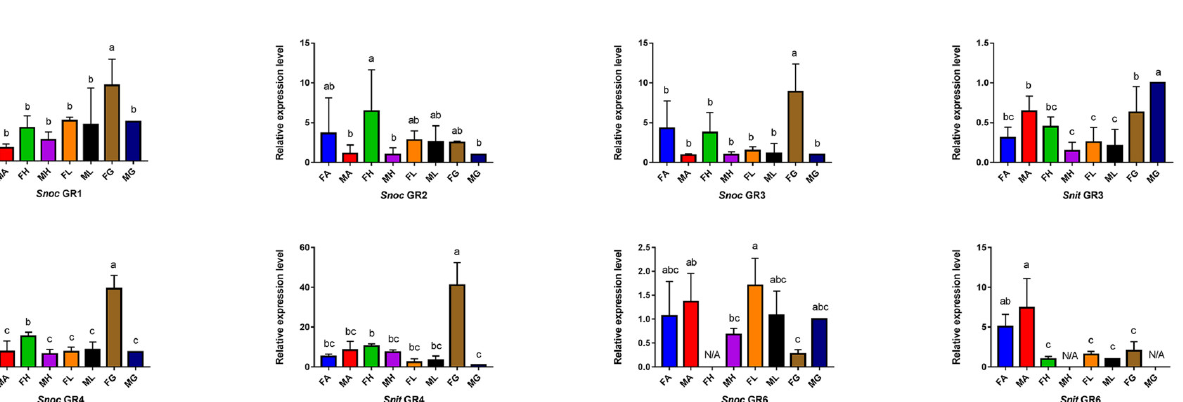
Figure 8. Relative expression levels of S. noctilio and S. nitobei GRs in different tissues of female and male adults by qPCR. FA: female antennae; MA: male antennae; FH: female head; MH: male head; FL: female legs; ML: male legs; FG: female genitals; MG: male genitals. The bar represents standard error and the different small letters (a–e) above each bar indicate significant differences ( p < 0.05). N/A indicates that the transcript level is too low to measure. 4. Discussion Compared with Symphyta species, studies on chemosensation have focused on the Apocrita, including A. mellifera , Campoletis chlorideae , N. vitripennis , M. pulchricornis , M. mediator , Macrocentrus cingulum Brischke [66–71]. In the Hymenoptera, there were some species with more ORs than siricids (41 and 43 in S. noctilio S. nitobei, respectively), such as 60 in M. mediator [69], 72 in C. cinctus [71], 80 in Chouioia cunea Yang [72], 99 in M.